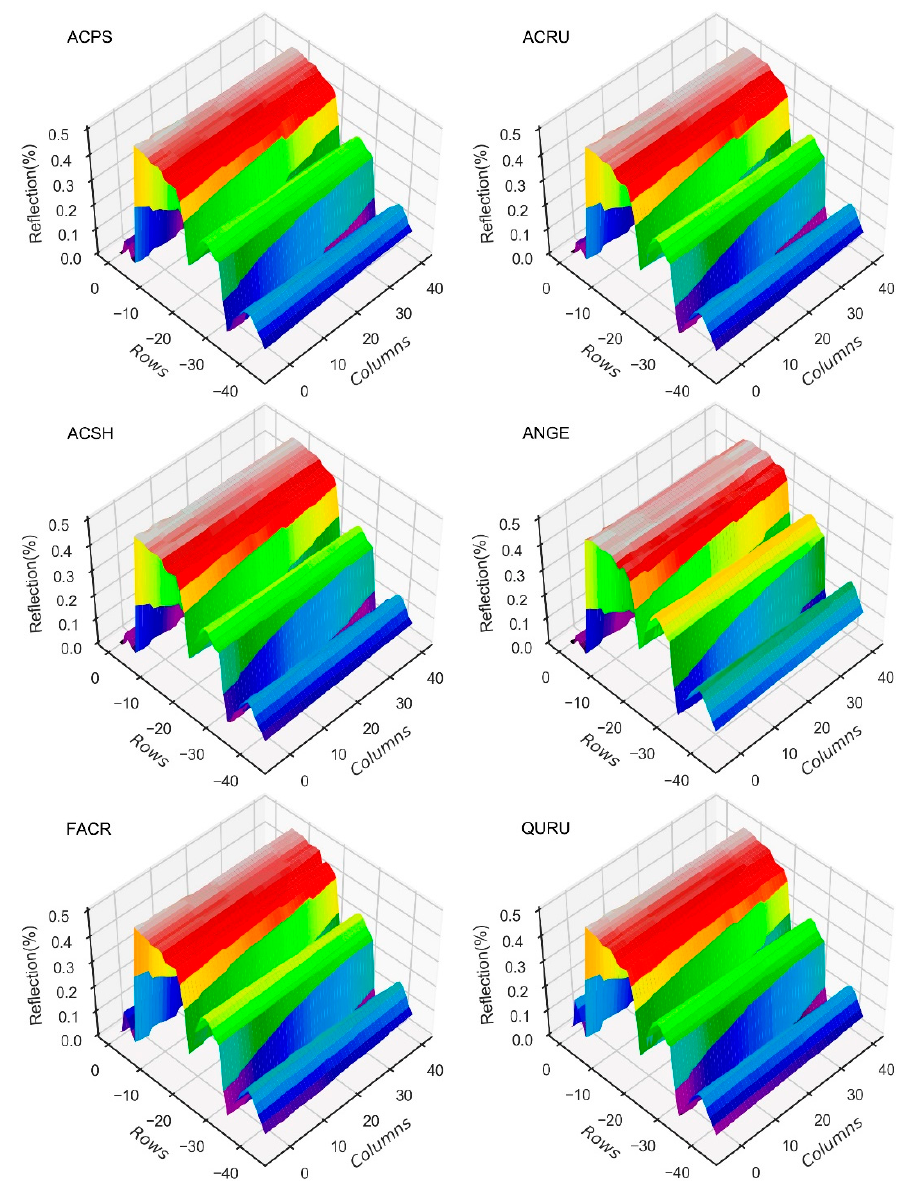
Figure 8. Average reflectance image-stretched 3D charts of six species. Reshaped grey images are stretched into 3D charts and colorized. Differences in structured data are one vertical dimension; while being reshaped into a 2D image, differences between lines will be scaled into a surface. Thus, CNN models may learn more features from image data than DCN and conventional models, which use 1D structured data.